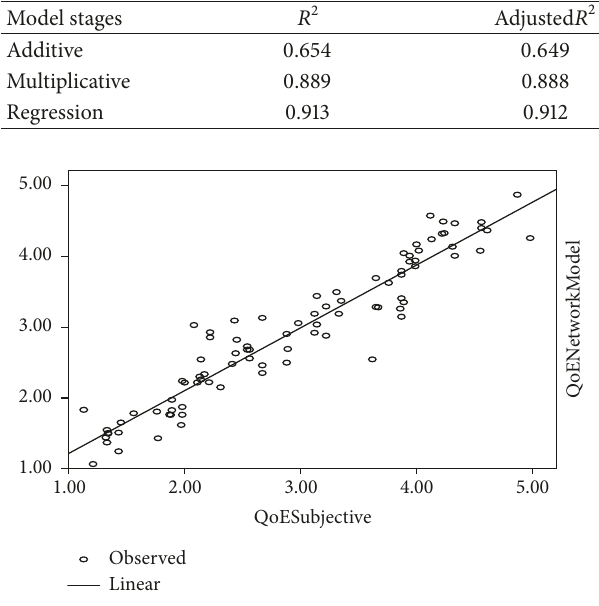
Figure 12: Accuracy of network video model.